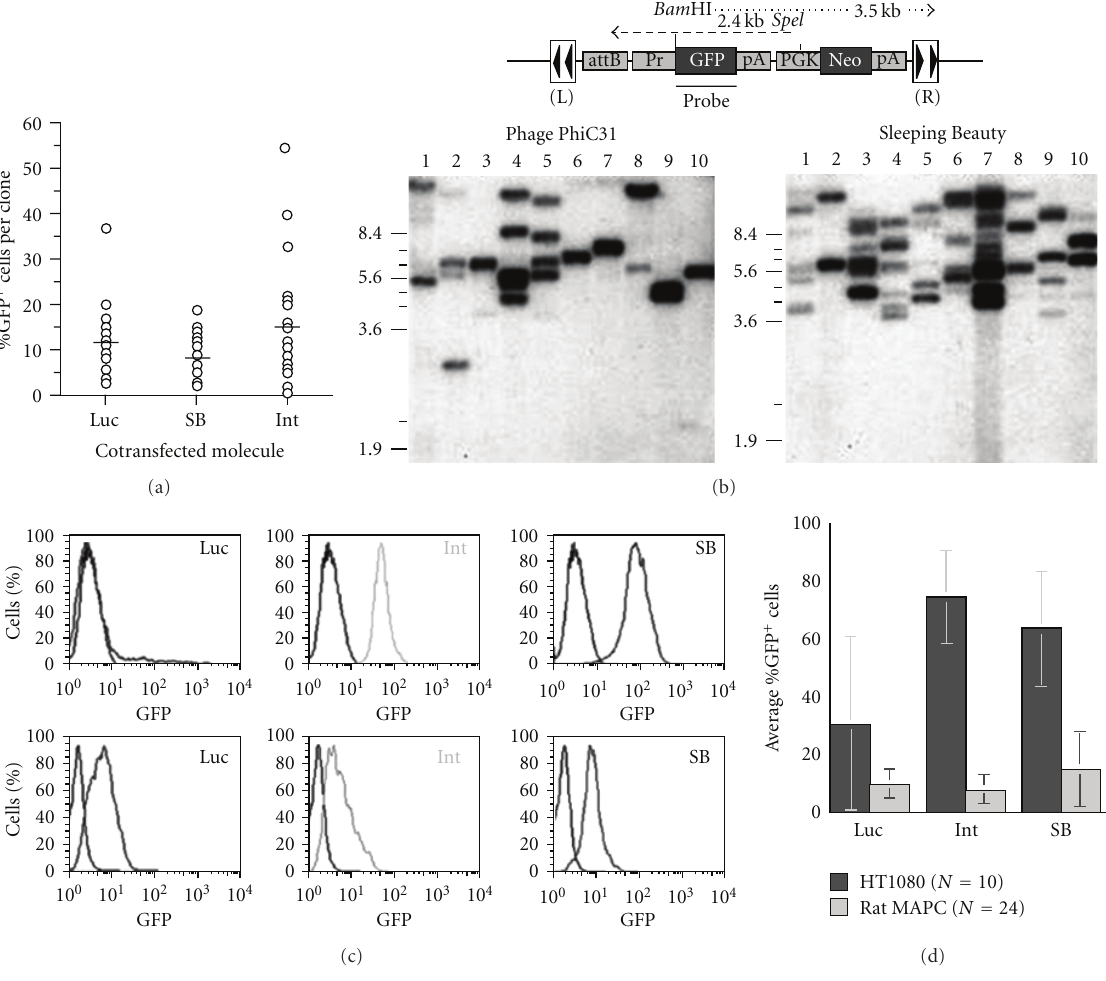
Figure 5: Stability of gene expression in MAPC. (a) Percentage GFP positive cells determined by flow cytometric analysis of 24 independent G418-resistant clones expanded from MAPC cotransfected with pKT2/NAG and Luc, SB, or Int expression vectors. Mean percentages of GFP+ cells for each condition are indicated by black bars. (b) Southern hybridization analysis of SB- and φ C31-mediated integration events. Top shows a schematic representation of the 6709 bp circular plasmid nucleofected into rat MAPC and the location of the GFP probe. See legend of Figure 1 for explanation of sequence elements contained in the vector. Spe I and Bam HI restriction sites were used for digestion of high molecular weight genomic DNA isolated from each G418-resistant clone. The Spe I site is located 2.4 kb from the breakpoint in the attB site. The Bam HI site is located 3.5 kb from the right IR/DR. The bottom figure shows the hybridization image of genomic DNA digested with Spe I ( φ C31) and Bam HI (SB) hybridized with the GFP probe. Clone number is indicated across the top, and marker positions are indicated along the sides. (c) Flow cytometry of representative stable G418-resistant clones exhibiting GFP expression in HT1080 human fibroblasts and rat multipotent adult progenitor cells (rMAPCs) with integrating vector alone (left panel), integrating vector plus φ C31 integrase (middle panel) and integrating vector plus SB transposase (right panel) compared to mock transfected cells of each type (black). (d) FACS analysis of individual clones was also measured and the average %GFP+ cells determined. Bar graph showing the average GFP% expression in HT12080 (dark bars) and rMAPC (light bars). Error bars represent standard